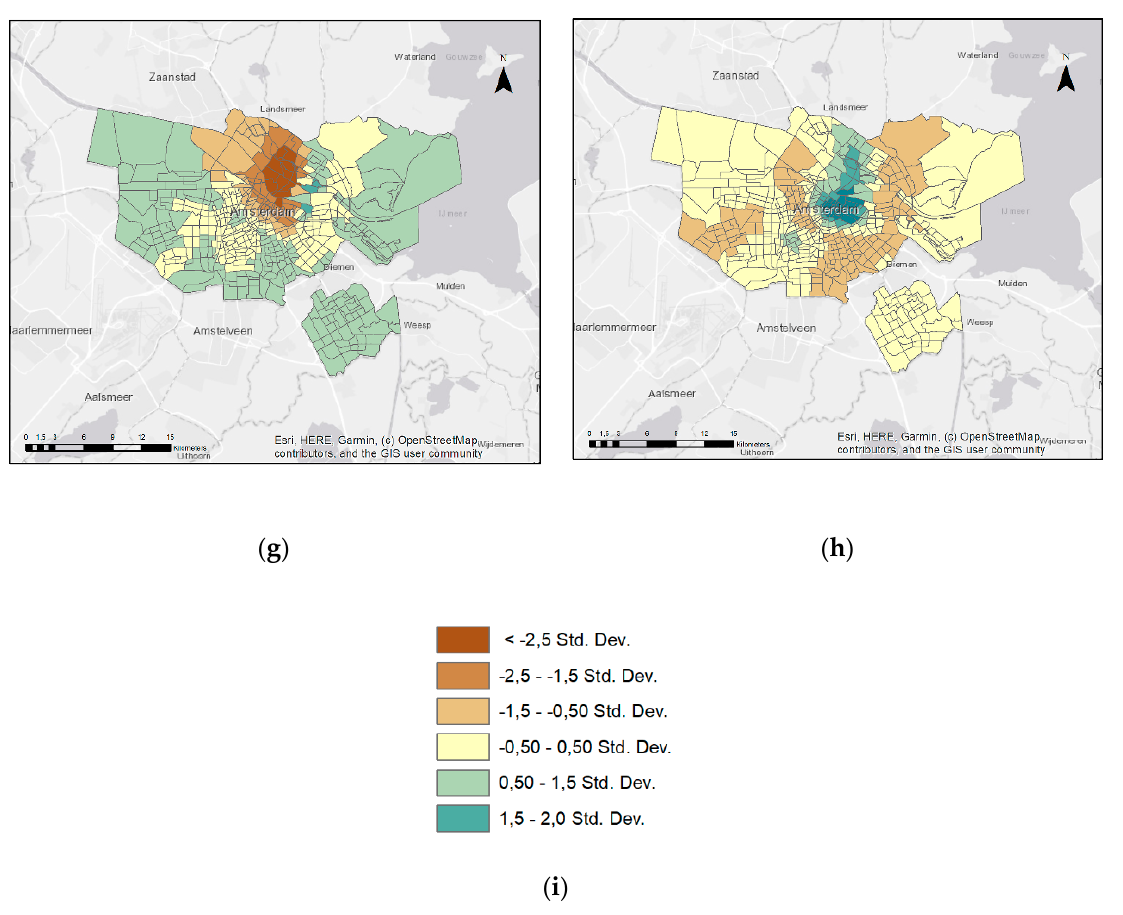
Figure 6. GWR residuals for each explanatory variable: ( a ) commercial heritages; ( b ) recreational heritages; ( c ) attractions; ( d ) eating locations; ( e ) open markets; ( f ) public toilets; ( g ) shopping locations; ( h ) tram-metro stops; ( i ) legend.